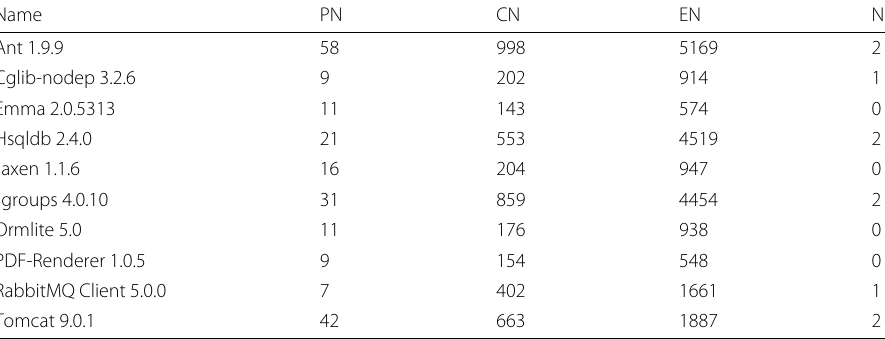
Table 1 Basic information of multiple Java software